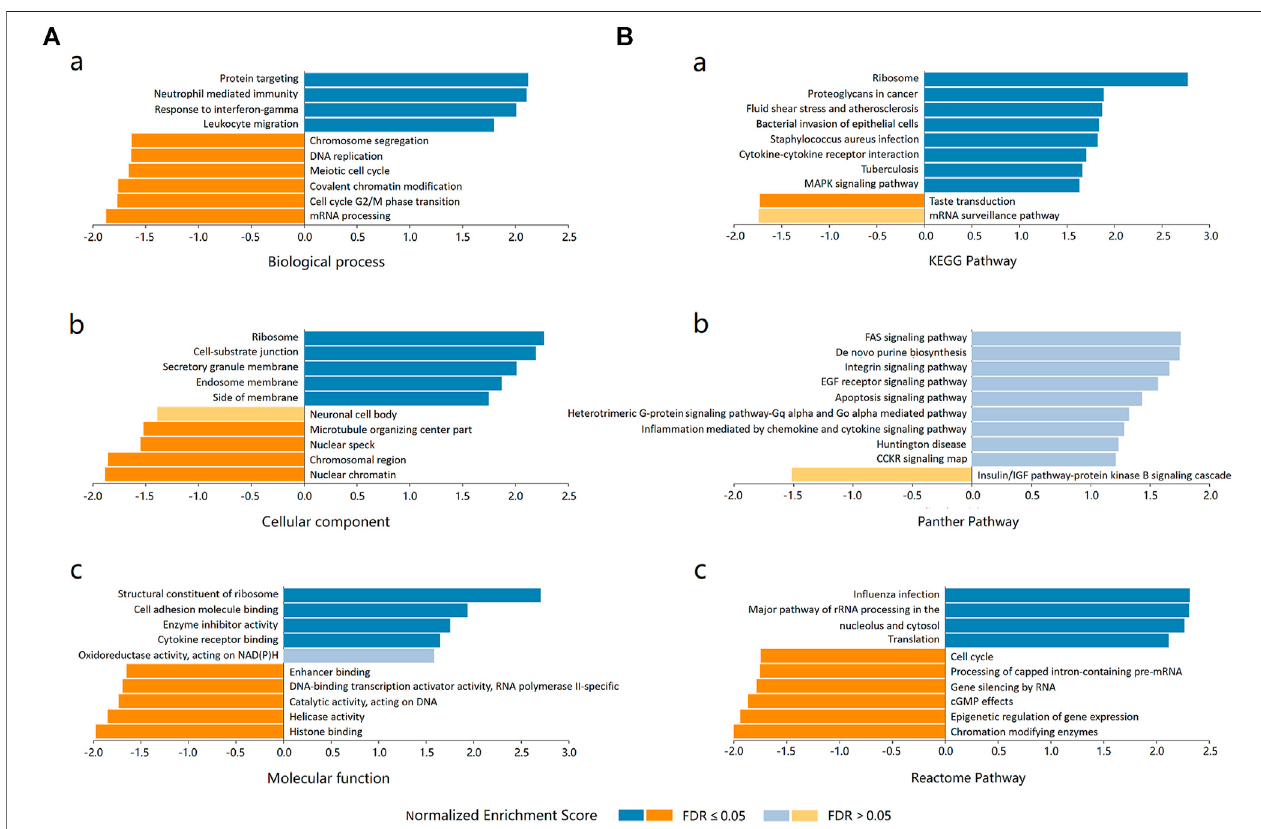
FIGURE 6 | Enrichment analysis of ADORA2B functional networks in LUAD. (A) Enriched Gene Ontology annotations of ADORA2B -correlated genes in LUAD (LinkedOmics). (a) Biological process. (b) Cellular component. (c) Molecular function. (B) Enrichment pathway analysis of ADORA2B -correlated genes in LUAD (LinkedOmics). (a) KEGG pathway. (b) PANTHER pathway. (c) Reactome